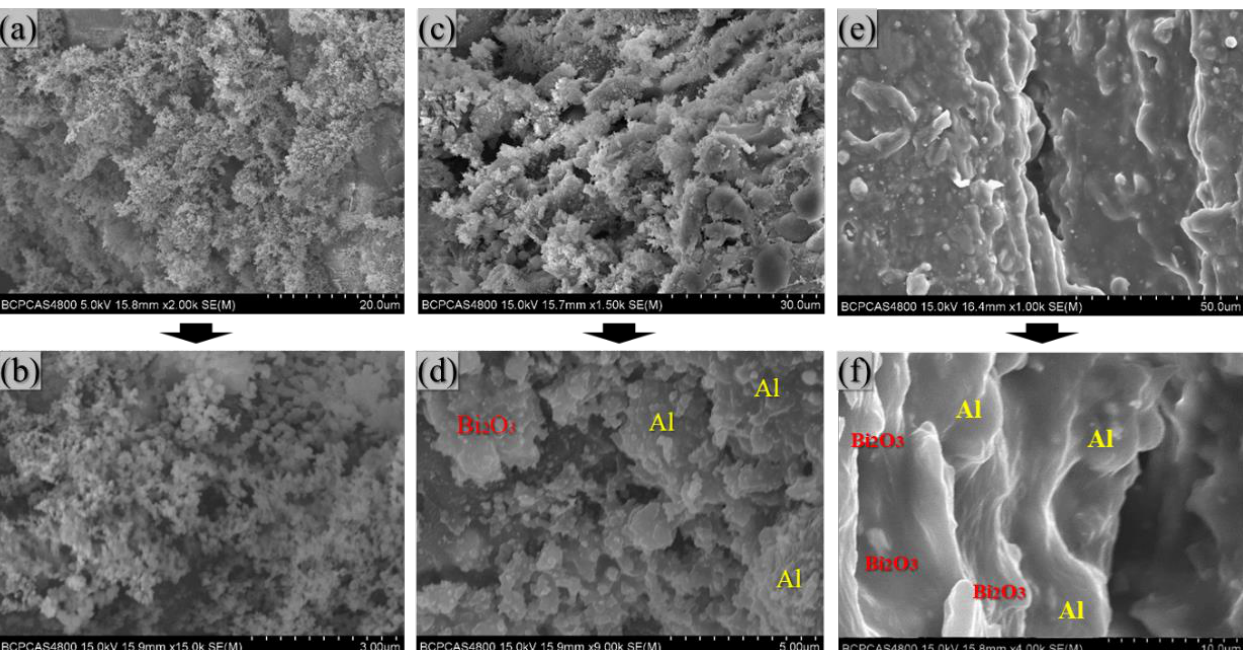
Figure 14. SEM photos of remnant: ( a , b ) fully reacted zone; ( c , d ) partial reacted zone; ( e , f ) melt zone.